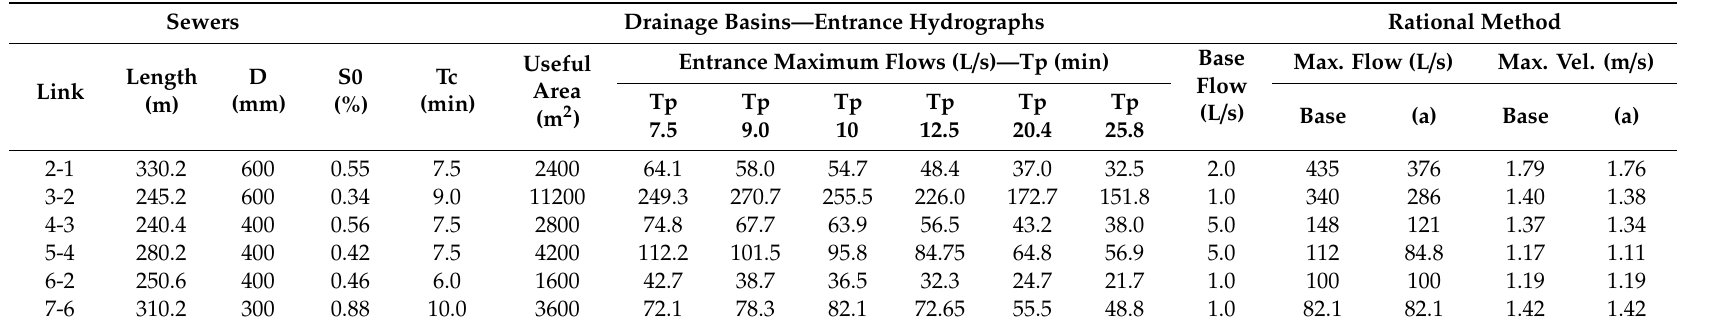
Table 2. Sewers and partial drainage basins data, maximum volumetric flow rates, and base flows of the entrance hydrographs; and rational method maximum volumetric flow rates and maximum average velocities for the simplified dendritic network